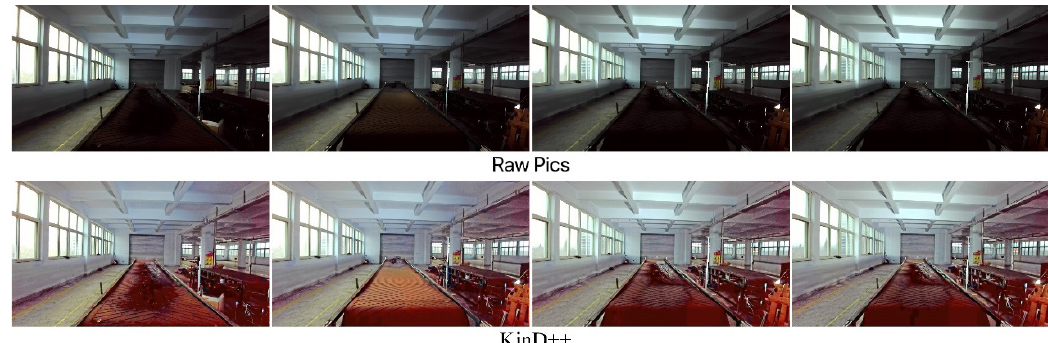
Figure 15. Enhancement of images with light sources in the evening by KinD++ algorithm.